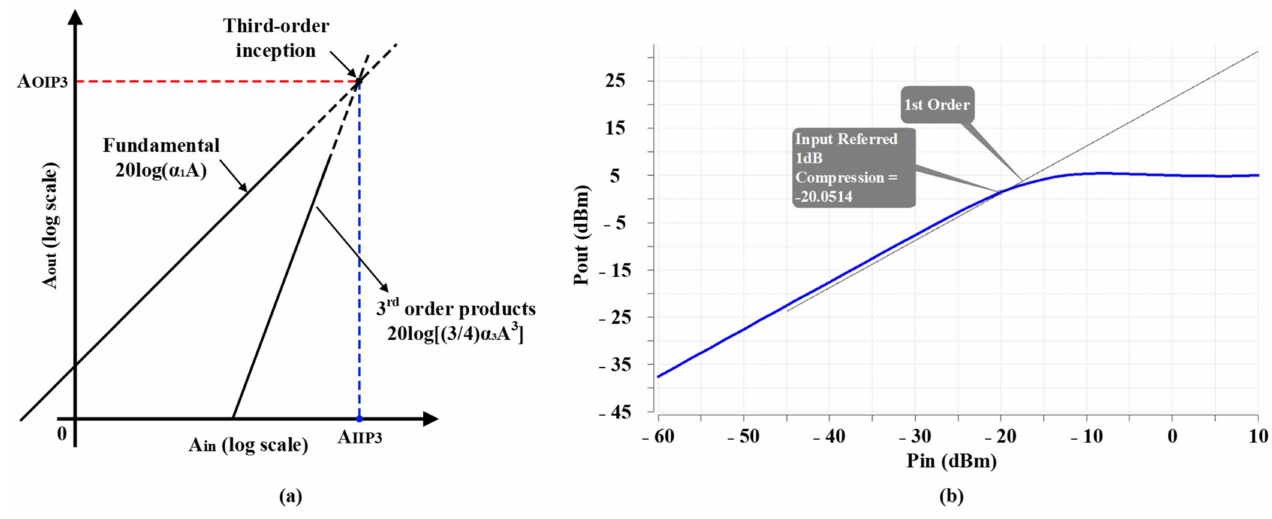
Figure 4. ( a ) Fundamental and third-order products amplitudes, and ( b ) post-layout simulation result of P 1dB performance at 1.8 GHz in LB for highest power gain step (G0x/G0).